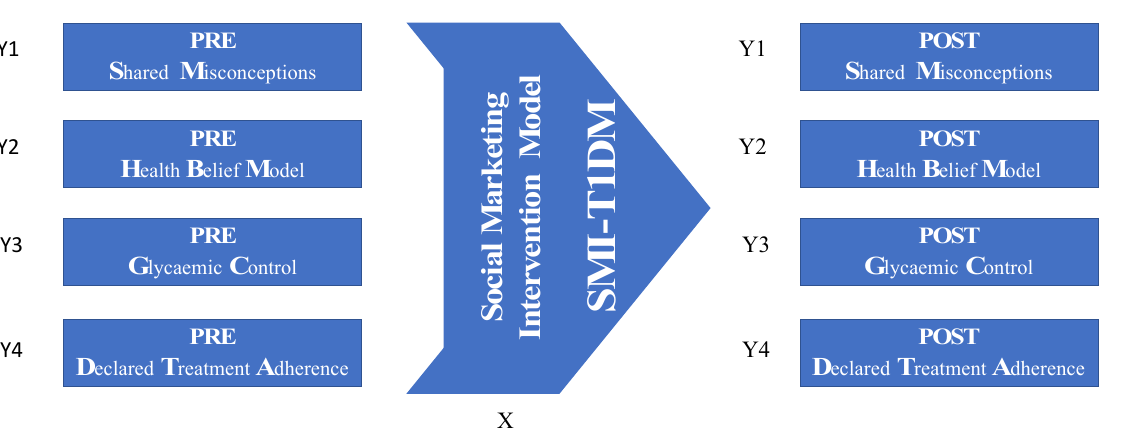
Figure 1. Scheme representing the research procedure.